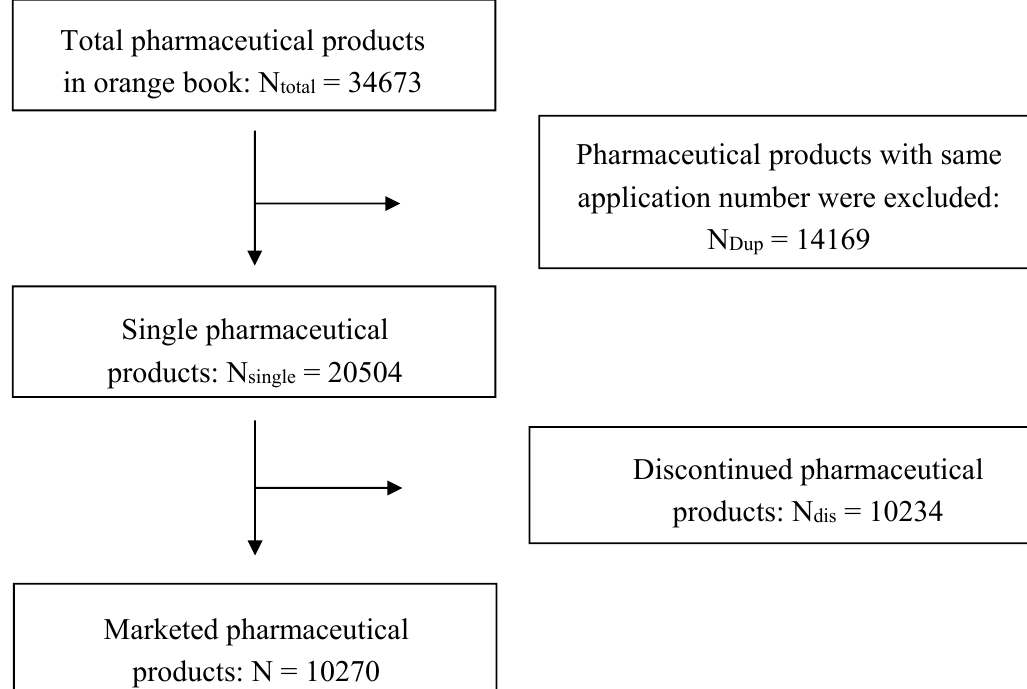
Figure 1. Marketed pharmaceutical products flow chart.